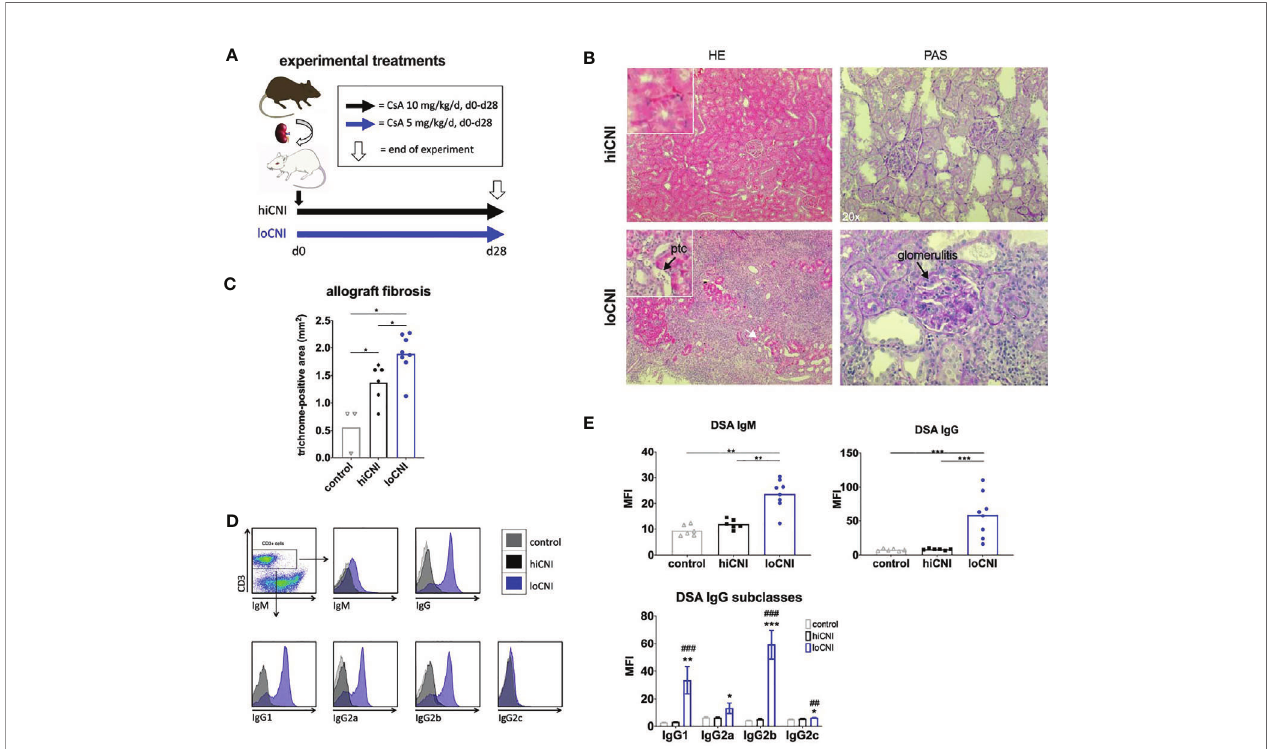
FIGURE 1 | Experimental treatments, rejection, fi brosis and DSA formation after Ktx. (A) Ktx groups and CsA treatment, (B) allograft histology showing peritubular capillaritis (ptc, arrow) and glomerulitis (arrow) in HE and PAS staining. (C) allograft fi brosis assessed by trichrome staining in control BN kidneys (n=3), and hiCNI (n=6) and loCNI (n=8) allografts (D) Representative fl ow cytometry data of DSA IgM, IgG and IgG subclasses measured by fl ow crossmatch and (E) DSA shown as MFI values in serum from controls (n=6), hiCNI (n=6) and loCNI (n=8). Data is shown as mean and individual data points; statistical signi fi cance between groups is shown as *p ≤ 0.05, **p<0.01, ***p<0.001. For DSA IgG subclasses, data is shown as mean ± SEM; *p ≤ 0.05, **p<0.01, and ***p<0.001 for loCNI vs. hiCNI and ## p<0.01, and ### p<0.001 for loCNI vs. control.